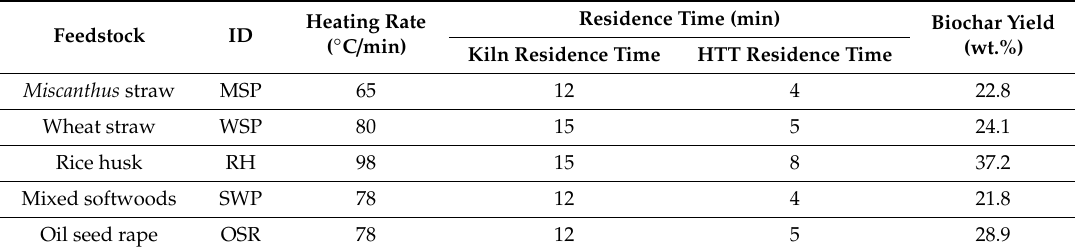
Table 1. Main pyrolytic process parameters adopted by UK Biochar Research Centre for the production of standardized biochar